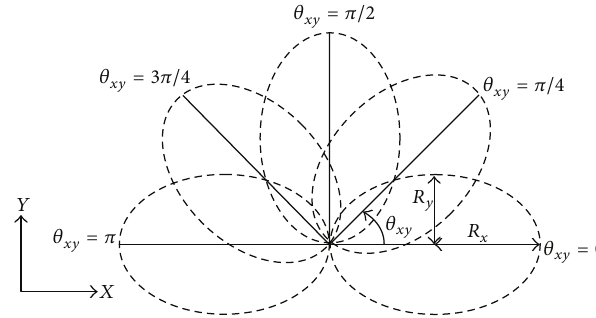
Figure 4: Projection of rotating ellipsoid on 𝑥 - 𝑦 plane.